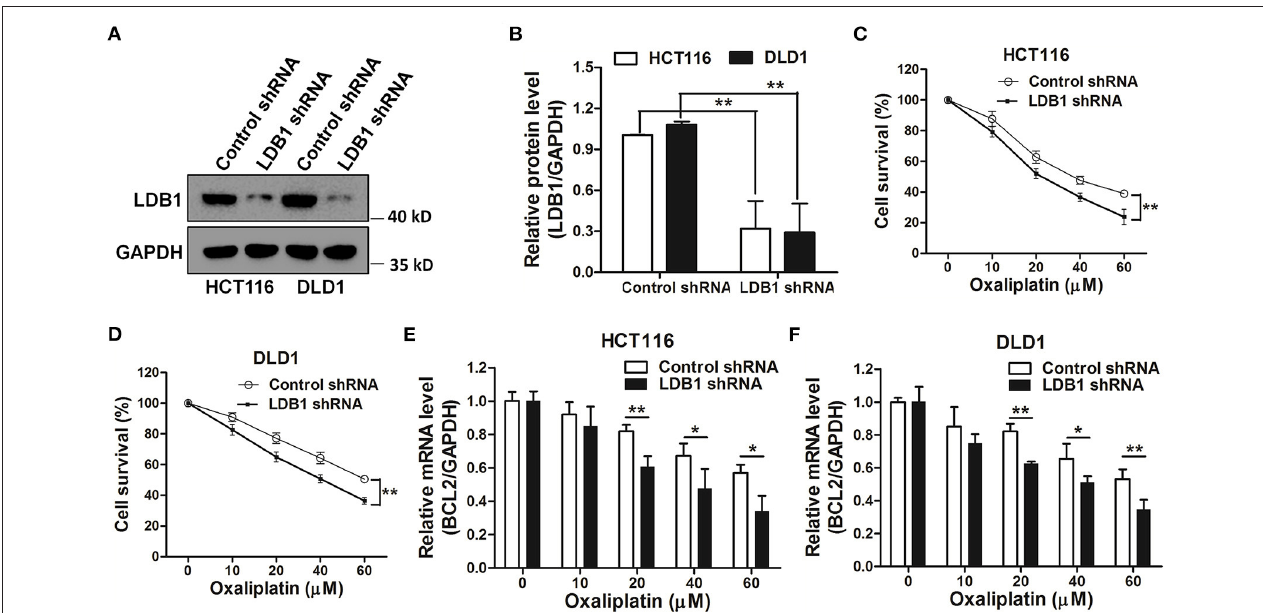
FIGURE 5 | Knockdown of LDB1 sensitizes the drug sensitivity of oxaliplatin in colorectal cancer cells. (A,B) The silencing effects of LDB1 shRNA in HCT116 and DLD1 cells were analyzed by western blot (A), and the optical density analysis was also carried out (B) . (C,D) HCT116 (C) or DLD1 (D) cells infected with control or LDB1 shRNA-derived lentivirus were incubated with indicated concentrations of oxaliplatin for 48h, followed by CCK-8 assay. (E,F) HCT116 (E) and DLD1 (F) cells infected with control or LDB1 shRNA-derived lentivirus were incubated with indicated concentrations of oxaliplatin for 48h, followed by qRT-PCR to assess the expression of BCL2 * p < 0.05, ** p <